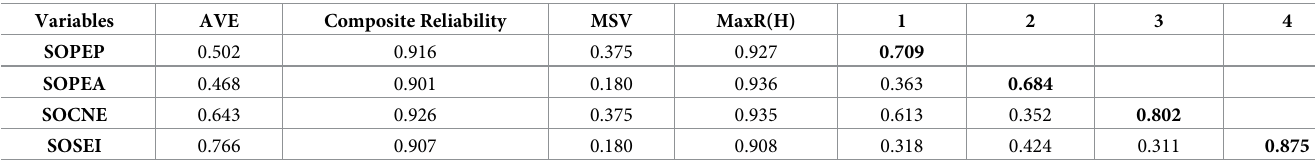
Table 6. Validity analysis (convergent & discriminant) (N = 268). Variables